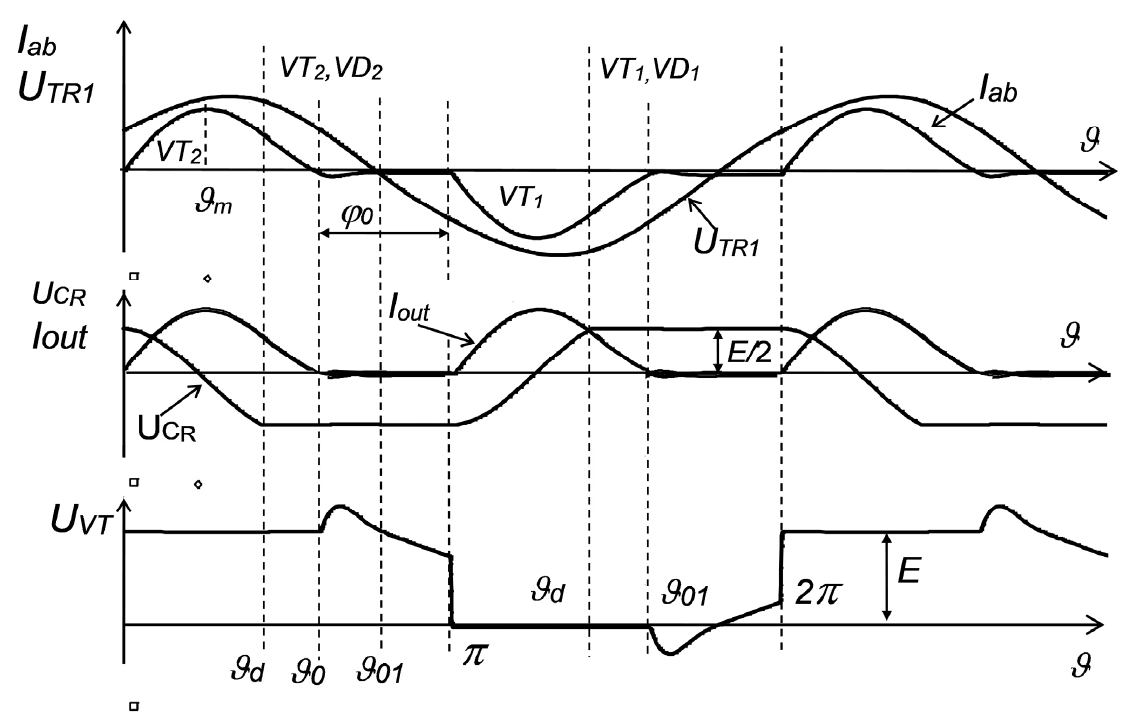
Figure 2. Basic timing diagrams of a half-bridge DC–DC converter with energy dosing. The indicated time diagrams show that in the operation of the power circuit during each half-period the following intervals are distinguished: 0 ÷ ϑ d , ϑ d ÷ ϑ 0, ϑ 0 ÷ ϑ 01 and ϑ 01 ÷ π . On the other hand, for the analysis of the resonant inverter, it is important to distinguish between the intervals (0 ÷ ϑ d ) in which energy is consumed from the power source and those in which the energy accumulated in the resonant elements supplies the output of the circuit. The operation of the considered power scheme for one of the two half-periods of its operation (0 ÷ π ) is explained in detail using a modal diagram, which is shown in Figure 3. In order to achieve convenient ratios, the following assumptions are made: the active and passive elements are ideal, and the times for their commutation are neglected. In addition, the processes in the scheme are considered after reaching a set mode of operation when there is periodicity and repeatability of the state variables. TRVD R3 E θ 01 ÷ π Figure 3. Modal diagram of a half-bridge DC–DC converter with energy dosing.